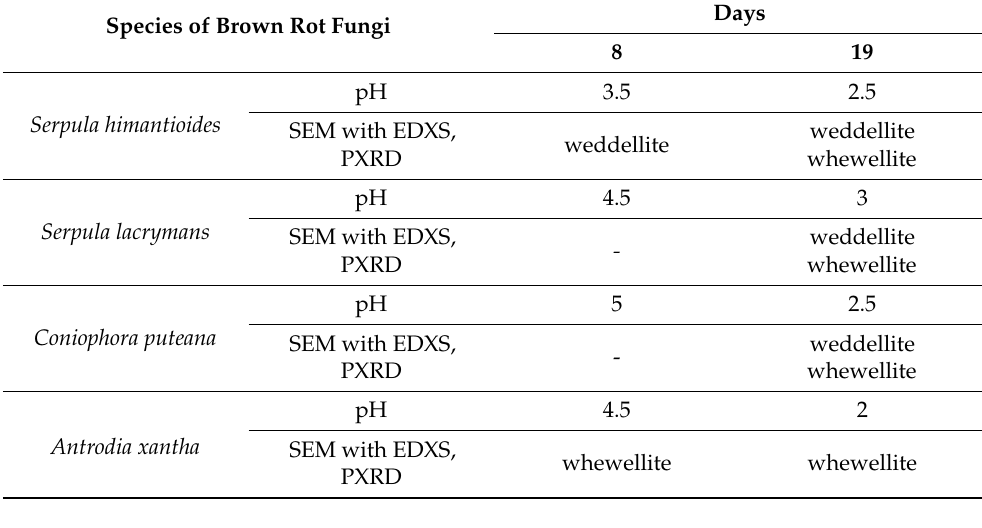
Table 5. The crystalline products of the reaction between marble and four species of brown rot fungi vs. pH of crystallization medium (SEM and PXRD).